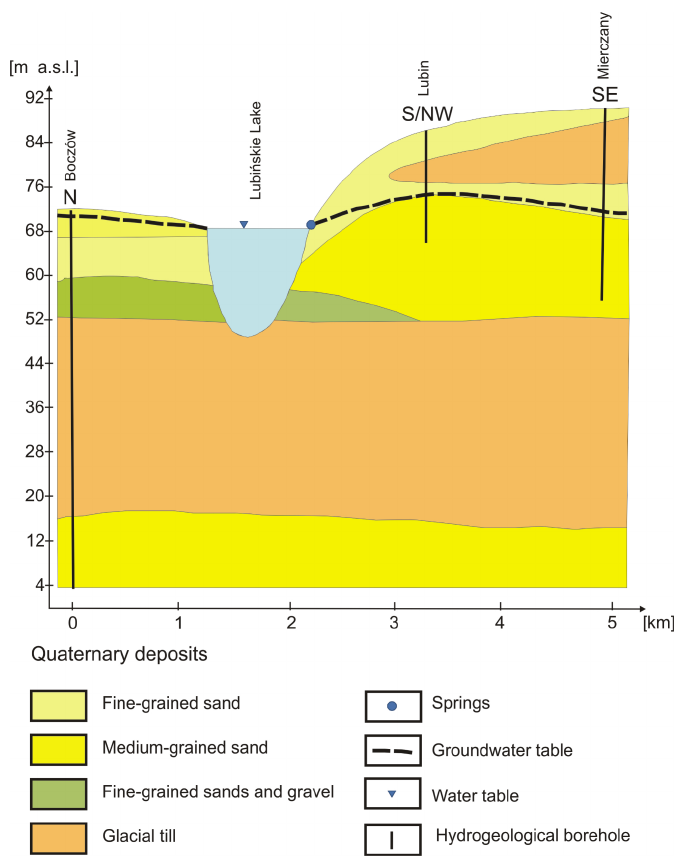
Figure 2. Hydrogeological cross-section of Lake Lubi ń skie drainage basin along the line Bocz ó w—Lubi ń skie Lake—Mierczany. As evidenced on an orthophotomap made in 2010 [49], woodlands and farmlands prevail in the catchment, covering the area of 2.7 and 2.6 km 2 , respectively (Figure 3). The remaining area is covered by waters and the urban territory of Lubin town. The lake is surrounded by forests from all sides, but on the west and south side the forest buffer is very narrow, only between about a dozen and several dozens of meters from the lake shore. Woodlands predominantly occur in the eastern part of the catchment, while arable lands are located in the western part.